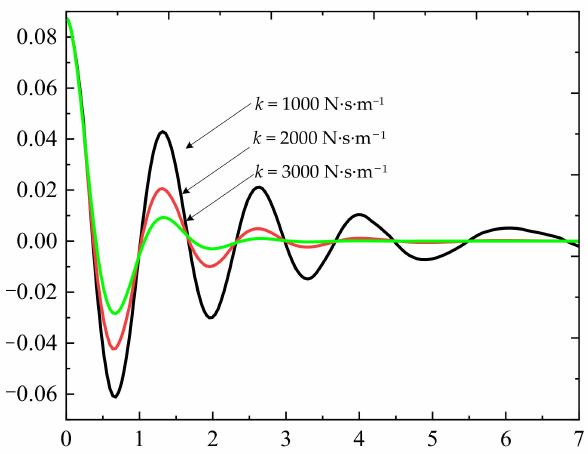
Figure 6. Influence of k on the attenuation process of the swaying angle.